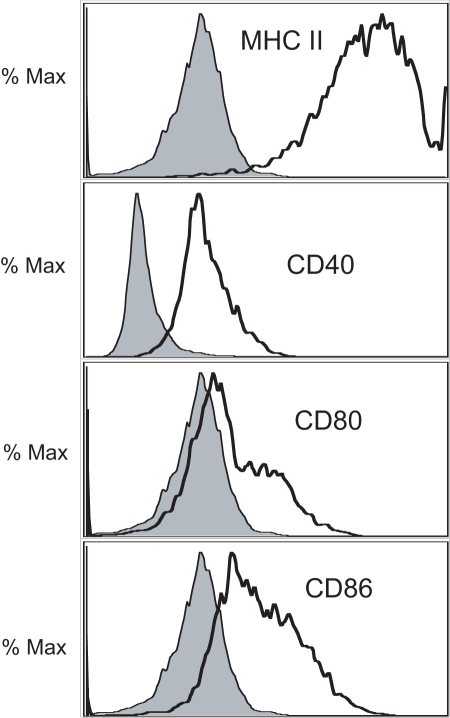
Expression of MHC II and costimulatory molecules by B cells from the lungs of chronic allergen challenged mice (day 37).Lung leukocytes were recovered from the lungs via enzymatic digests and the expression of MHC II, CD40, CD80, and CD86 on CD19+ cells were determined by flow cytometry. Representative histograms (from a group of n = 5) are shown. Shaded histograms represent isotype controls, with overlays representing MHC II, CD40, etc.